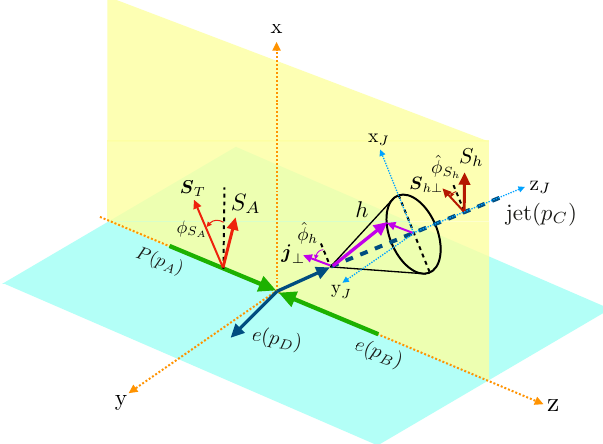
Figure 3 . Electron and hadron in jet production from back-to-back electron-proton collision, where S A indicates the spin of the incoming proton, S h is the spin of the produced hadron in a jet. The jet axis and colliding direction define the xz